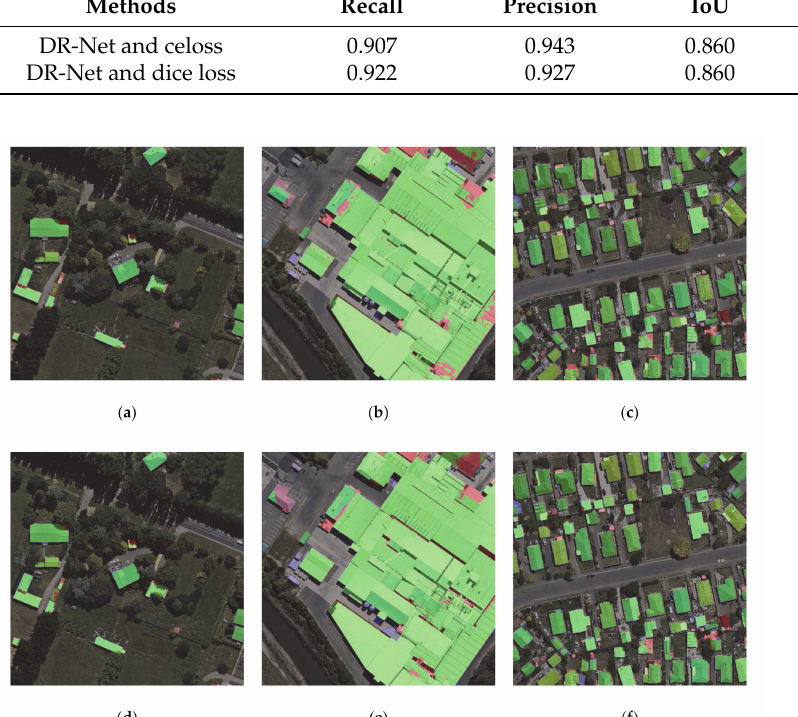
Figure 4. The visualization of building extraction results based on different loss function. The first row ( a – c ) shows the results of DR-Net based on the binary cross entropy loss, and the second row ( d – f ) shows the result of DR-Net based on the dice